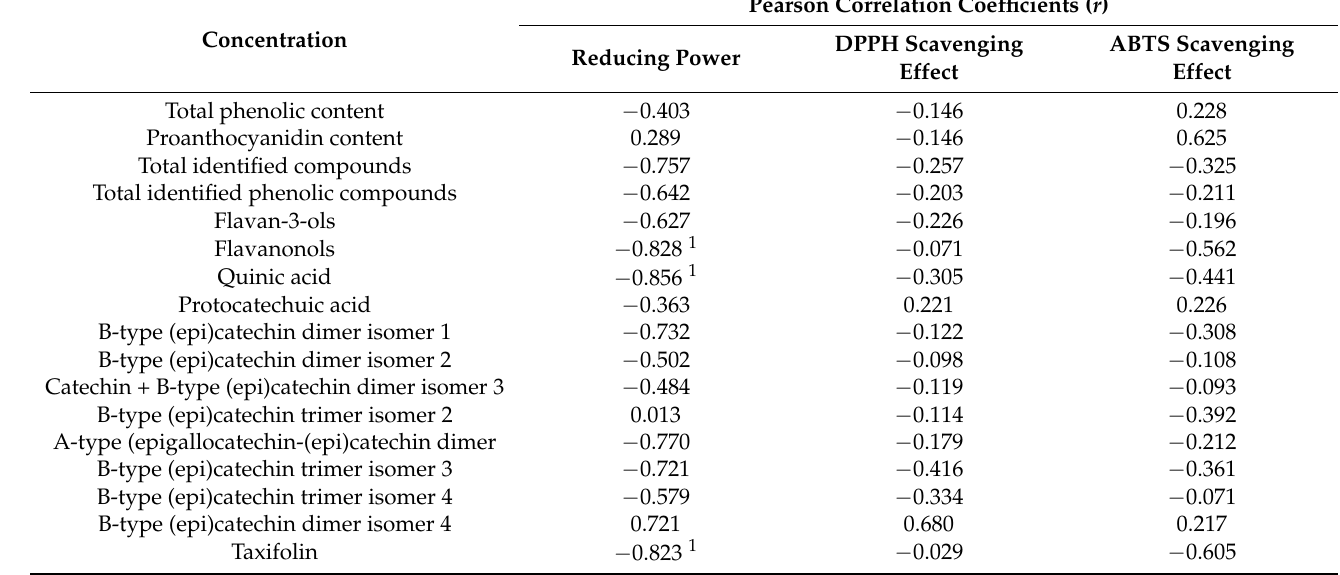
Table 6. Pearson correlation coefficients between the concentration of compounds and the IC 50 values of reducing power, DPPH, and ABTS scavenging effects exhibited by Pinus pinaster Ait. and Pinus pinea L. bark polar